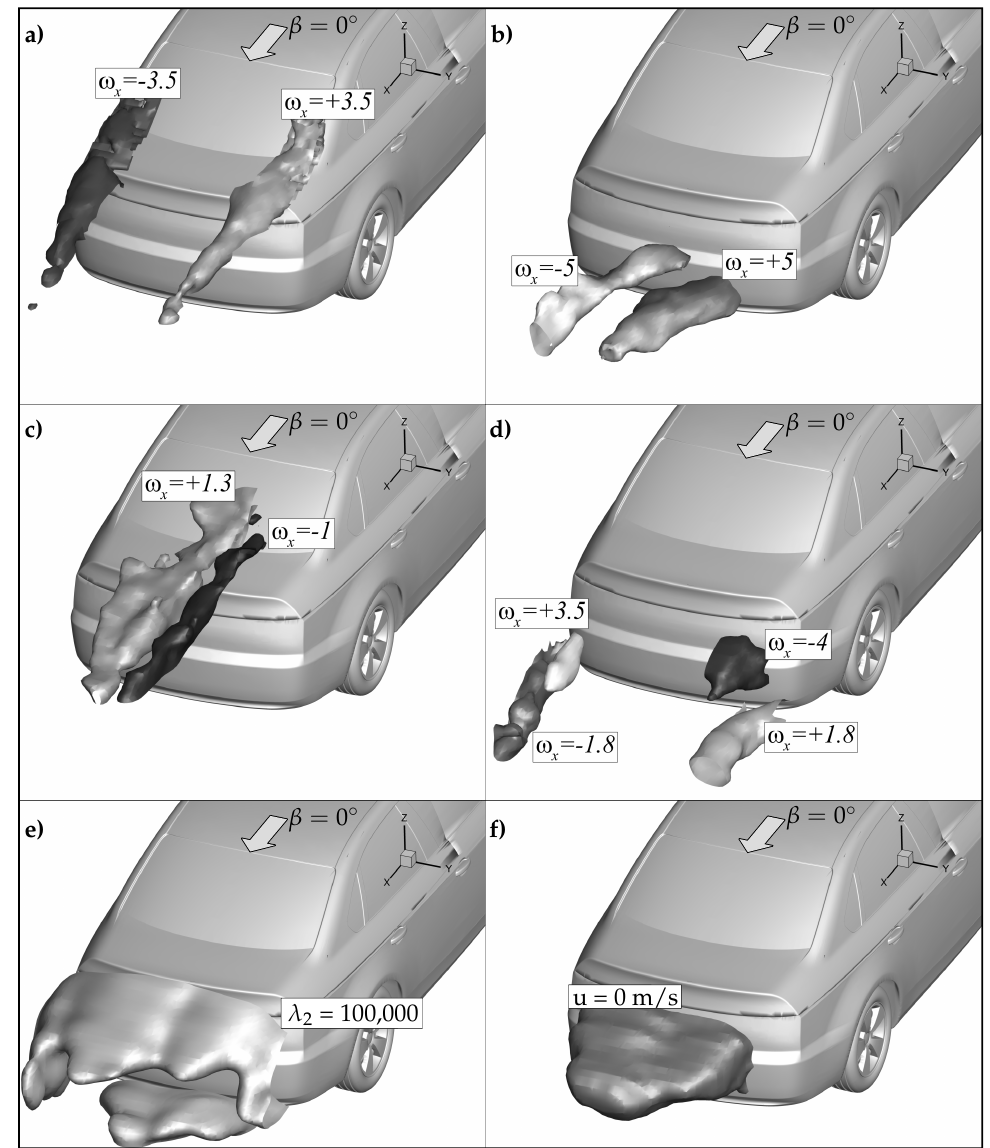
Figure 7. Vortical structures along the downstream direction of the rear window and the vehicle base surface without side wind: ( a – d ) streamwise vortices, ( e ) λ 2 -criterion, and ( f ) recirculation area.